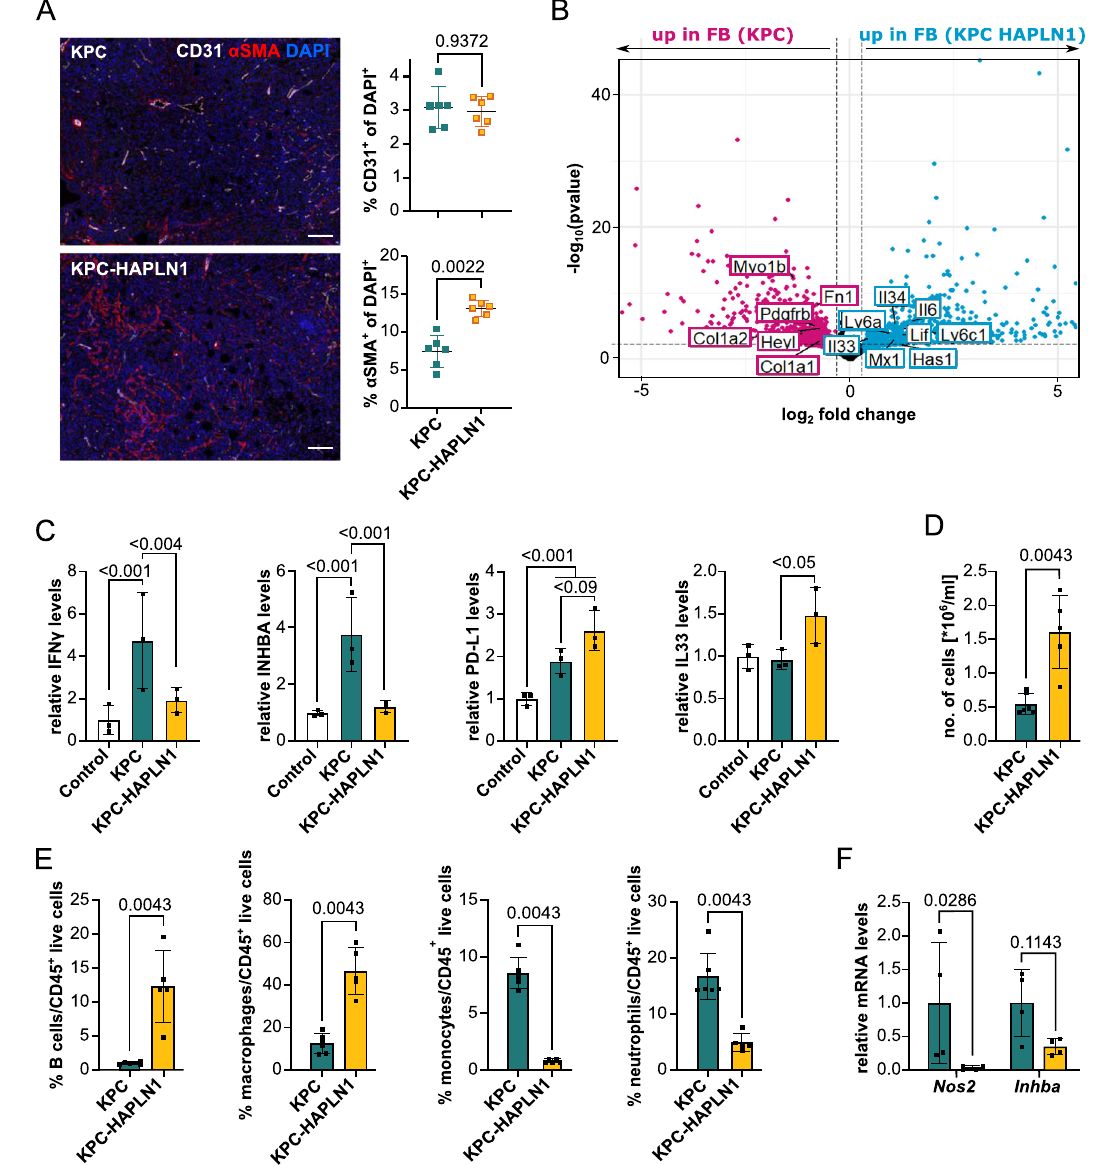
Fig. 6 | HAPLN1 modi fi es the immune microenvironment. A CD31/ α SMA immuno fl uorescencestainingontumors.Representativeimagesandquanti fi cation ofCD31 + cellsand α SMA + cellsareshown.Scalebar:50 µ m. n =6. B RNAsequencing of PDPN + isolated cancer-associated fi broblasts from KPC or KPC-HAPLN1 tumors. Pink dots mark genes signi fi cantly up in CAFs from KPC, blue dots genes sig- ni fi cantlyupinCAFsfromKPC-HAPLN1tumors.Somegenesofinterestarelabeled. n =3. C Serum of healthy, or KPC/KPC-HAPLN1-injected mice at day 11 of tumor growth was analyzed using the scioCD protein array. Relative protein levels